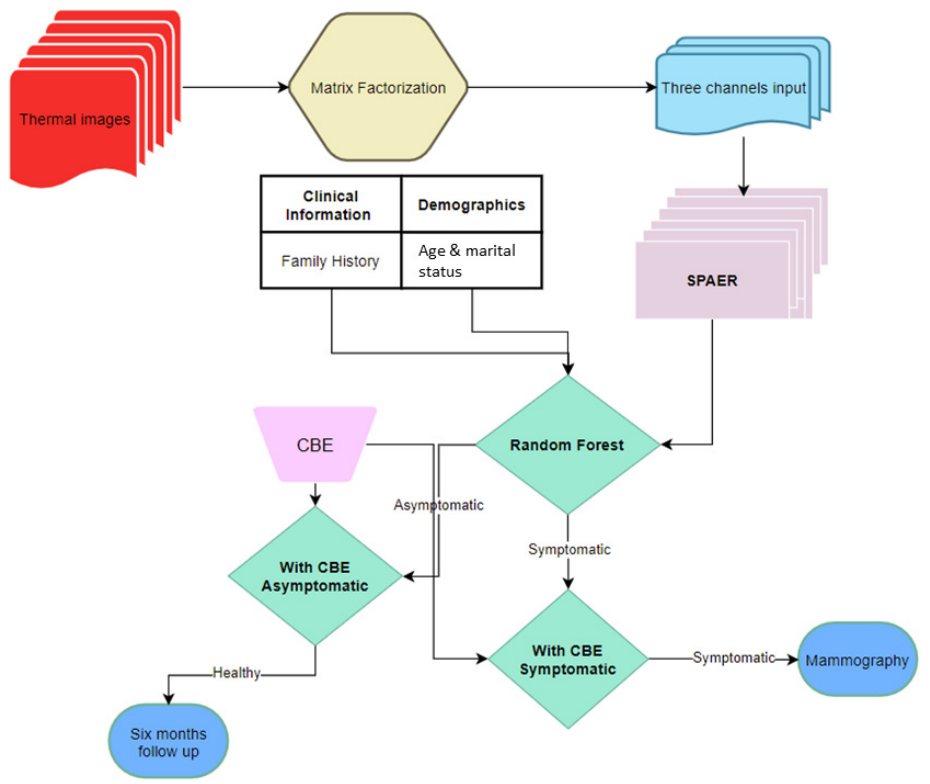
Figure 2. Scheme of the presented thermographic system to be used prior to mammography for the initial diagnosis of breast cancer along with clinical breast examination (CBE). initial diagnosis of breast cancer along with clinical breast examination